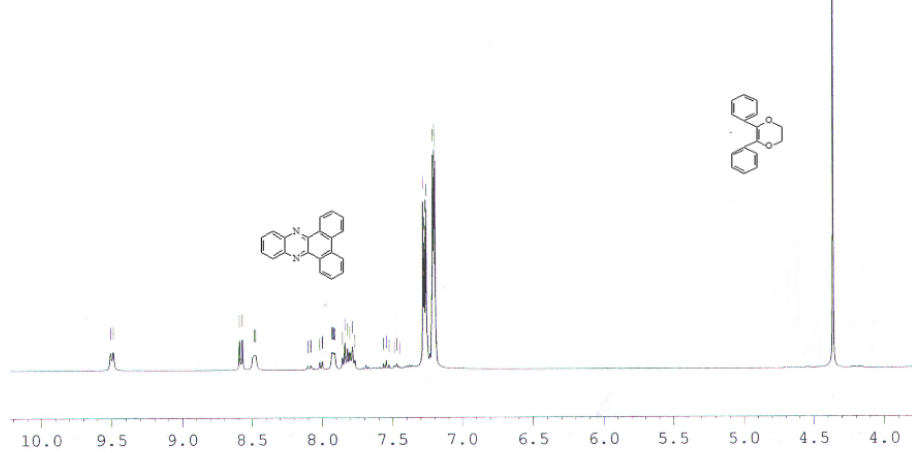
Figure 3. 1 H NMR spectrum of a mixture of dibenzo[a.c]phenazine sensitizer and 2,3-diphenyl- p - dioxene in CDCl 3 before irradiation.